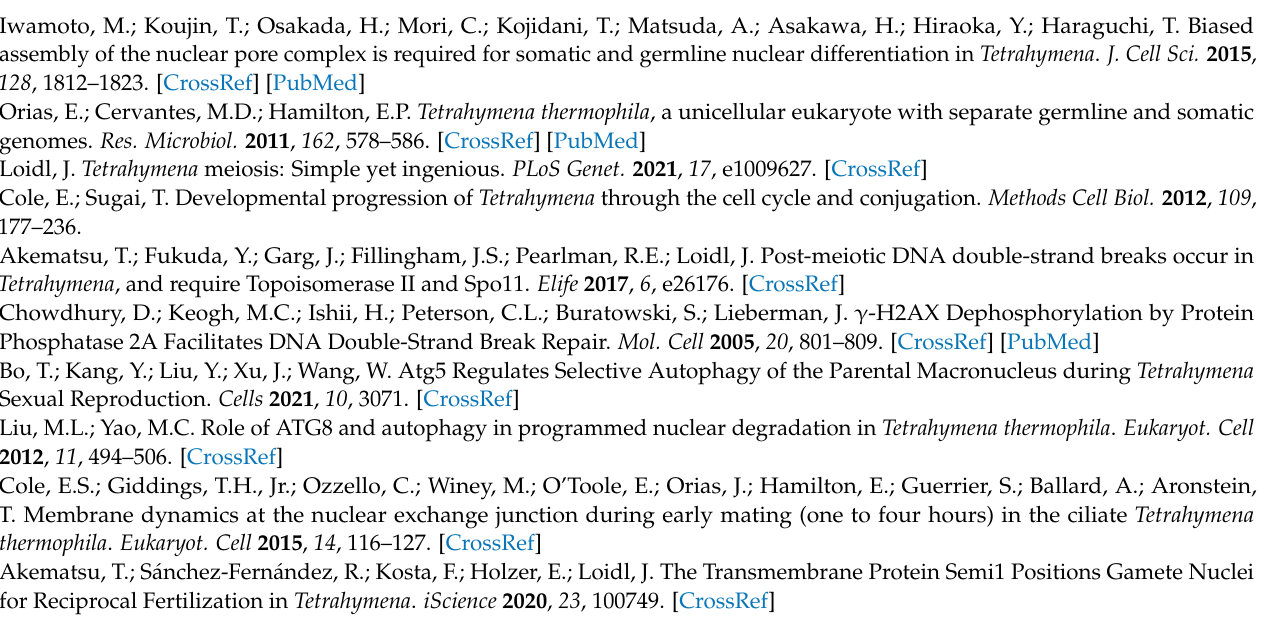
Supplemental Figure S5: Subcellular localization of Tetrahymena Snf2 family proteins localizing to the MAC. Supplemental Figure S6: Subcellular localization of Tetrahymena Snf2 family proteins localizing to the MIC. Supplemental Figure S7: Subcellular localization of Tetrahymena Rad54 localizing to both the nuclei. Supplemental Figure S8: Subcellular localization of Tetrahymena Smarcal1A. Supplemental Figure S9: Generation of ISWIG Tt ∆ , Lodestar Tt ∆ , and RAD5 Tt ∆ cells and PCR confirmation. Sup- plemental Figure S10: Indirect immunofluorescence images indicating the appearance of IswiG Tt and Rad5 Tt in the selected hMIC in which γ -H2AX foci vanished. Supplemental Table S1: List of Snf2 genes found in Tetrahymena genome. Supplemental Table S2: Primer sets for C-terminal EGFP- tagging and N-terminal mCherry-tagging. Supplemental Table S3: Antibodies used in the indirect immunofluorescence observations. Supplemental Table S4: Primer sets for somatic gene knockout plasmids. Supplemental Table S5: Primer sets for PCR evaluating somatic gene